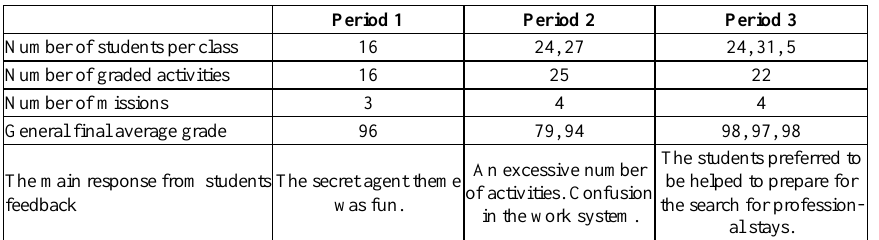
Table 2. Characteristics of classes and periods in which the secret agent theme was used